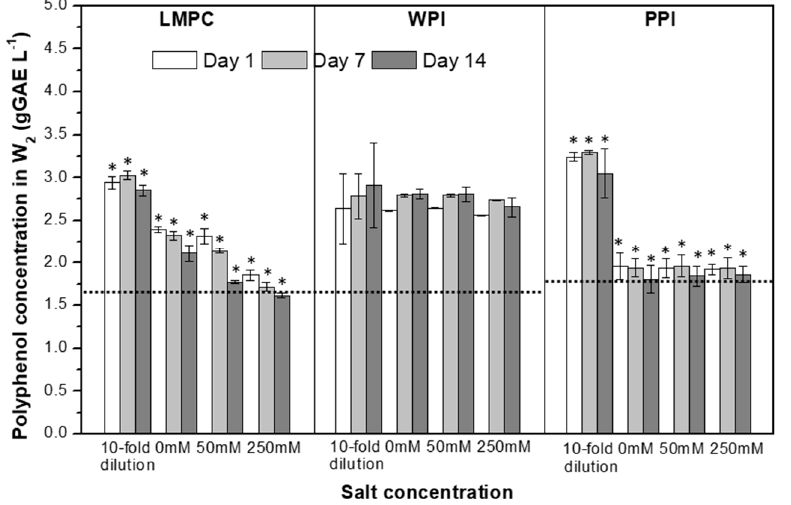
Figure 13. Polyphenol concentration in W 2 of emulsions stabilized with LMPC, WPI and PPI during a quiescent storage of 14 days at room temperature. Emulsions were subjected to different conditions of 10-fold dilution by water ( Δ ( П W2 – П W1 ) = − 0.54 MPa), 0 ( Δ ( П W2 - П W1 ) ≈ 0 MPa, with no extra addition of salt, kept at 25 °C), 50 mM NaCl ( Δ ( П W2 – П W1 ) = 0.46 MPa) and 250 mM NaCl ( Δ ( П W2 – П W1 ) = 2.56 MPa). Asterisk labeled above the bars points to the appearance of a precipitate during the polyphenol analysis. Dashed lines indicate the value in freshly produced emulsions.